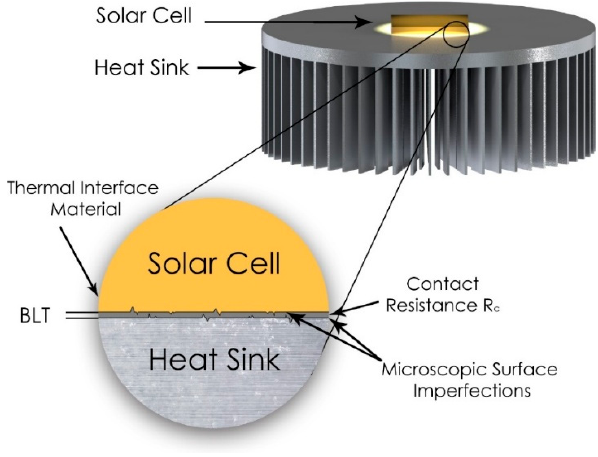
Figure 1. Illustration of the function of the thermal interface materials for heat removal from the solar cell under concentrated light. cell under concentrated